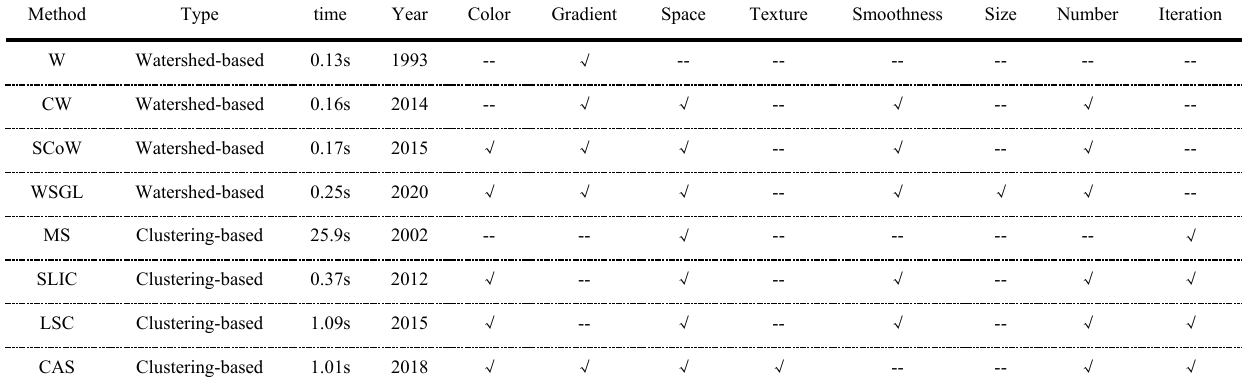
Table 1. Superpixels